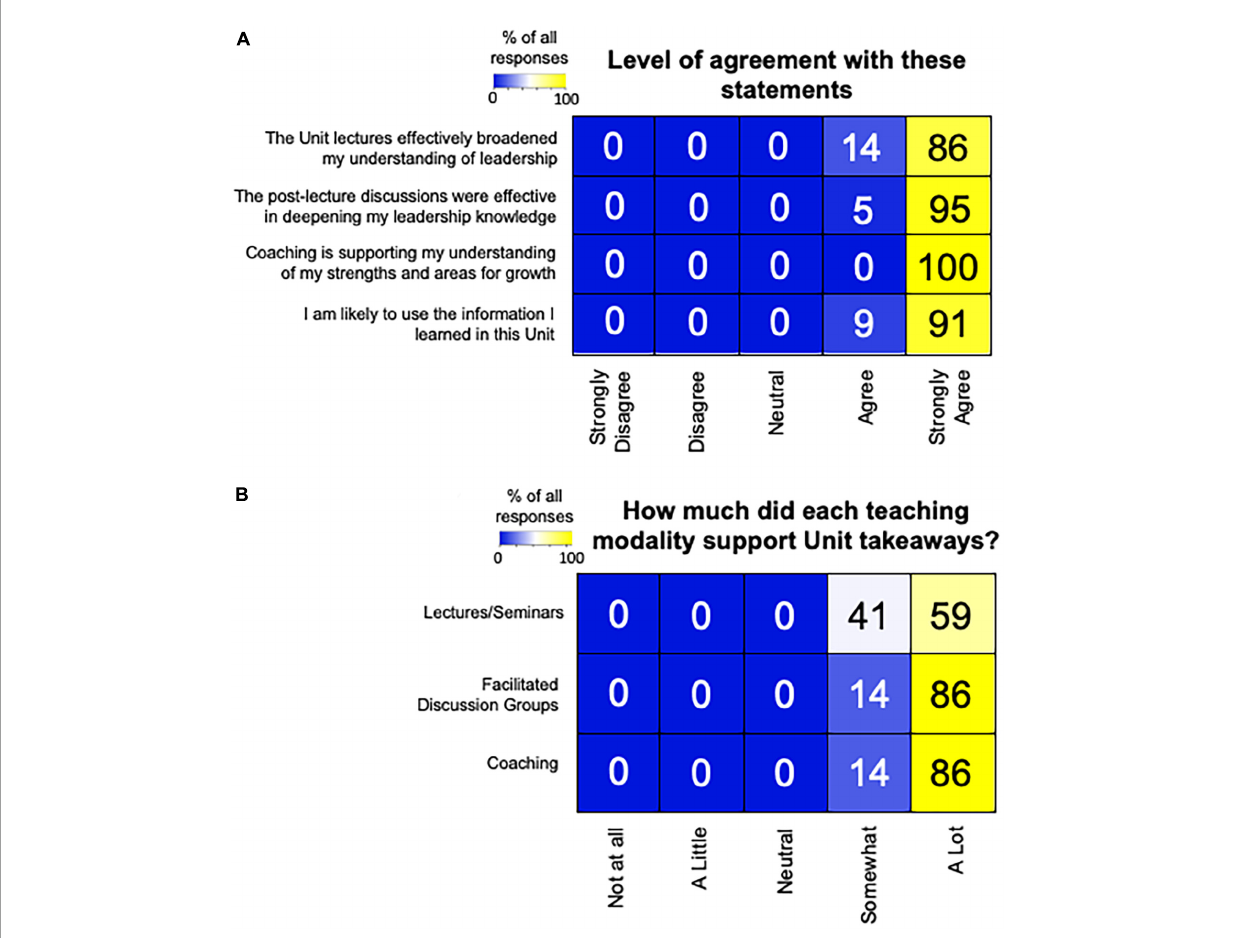
FIGURE3 Aggregate unit survey data. (A) A heatmap depicting participant level of agreement with survey statements. (B) A heatmap depicting participant opinions regarding the three main teaching modalities. Data for both panels (A,B) are shown as a percentage of total responses across all five